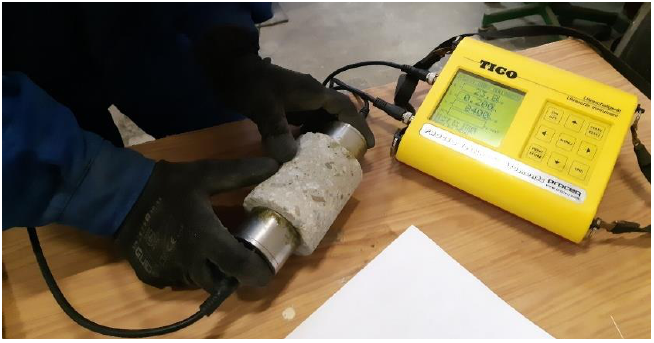
Figure 2. UPV testing.